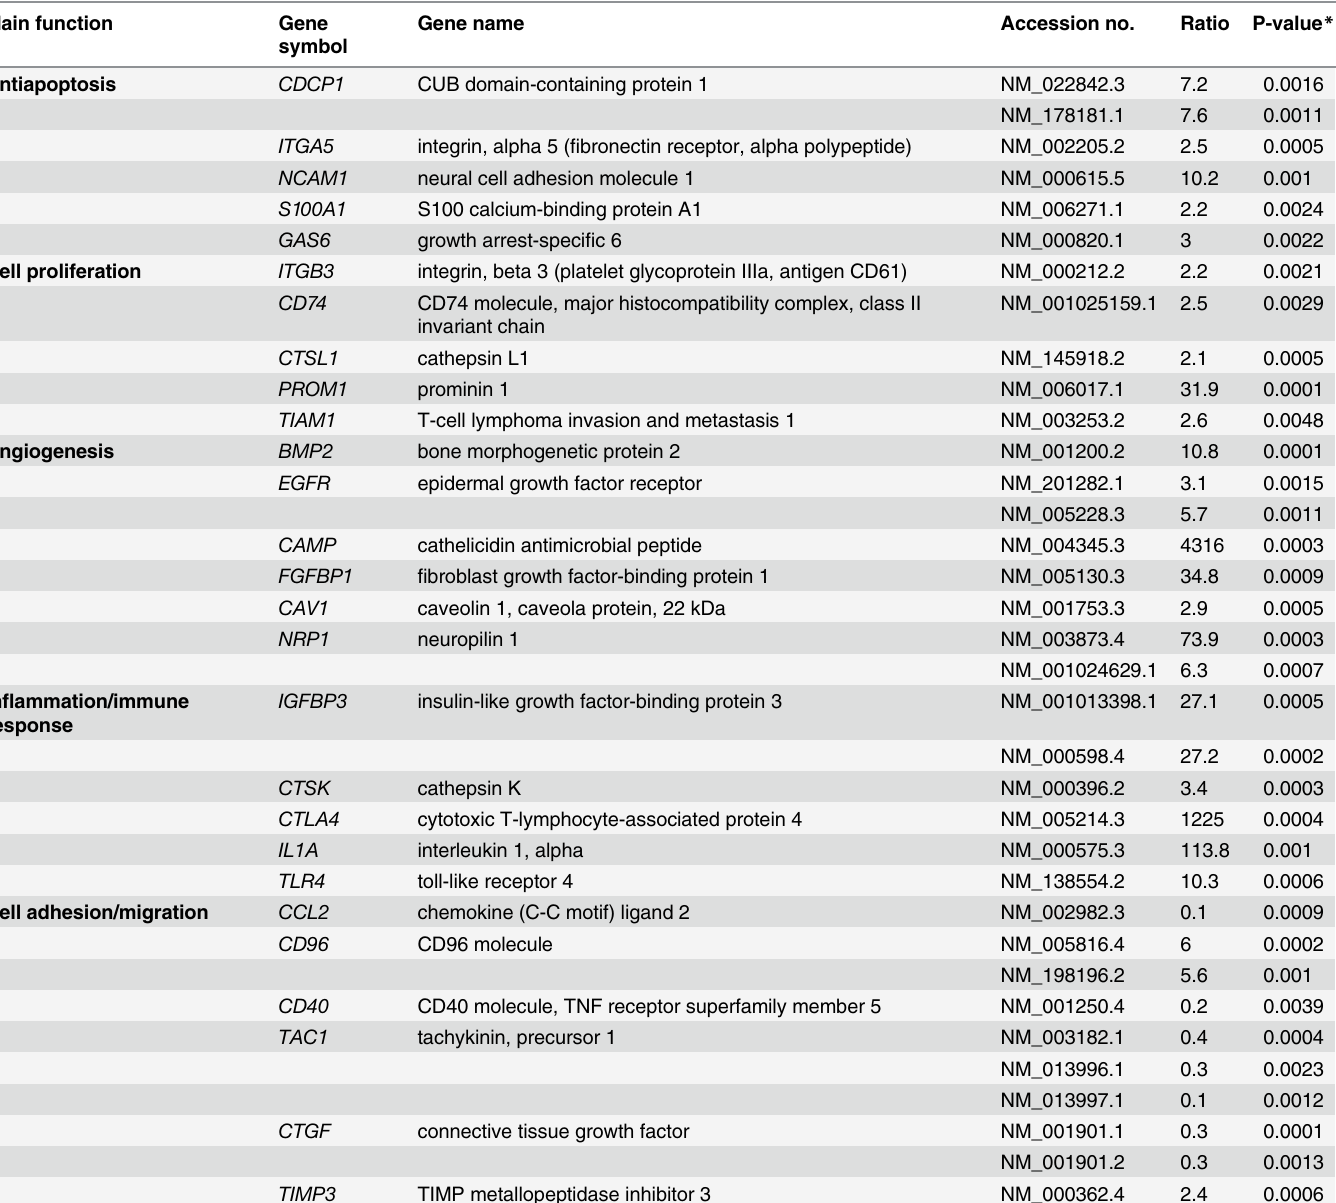
Table 2. A list of differentially expressed genes in CD10-A375 cells compared with mock-A375 cells. Main